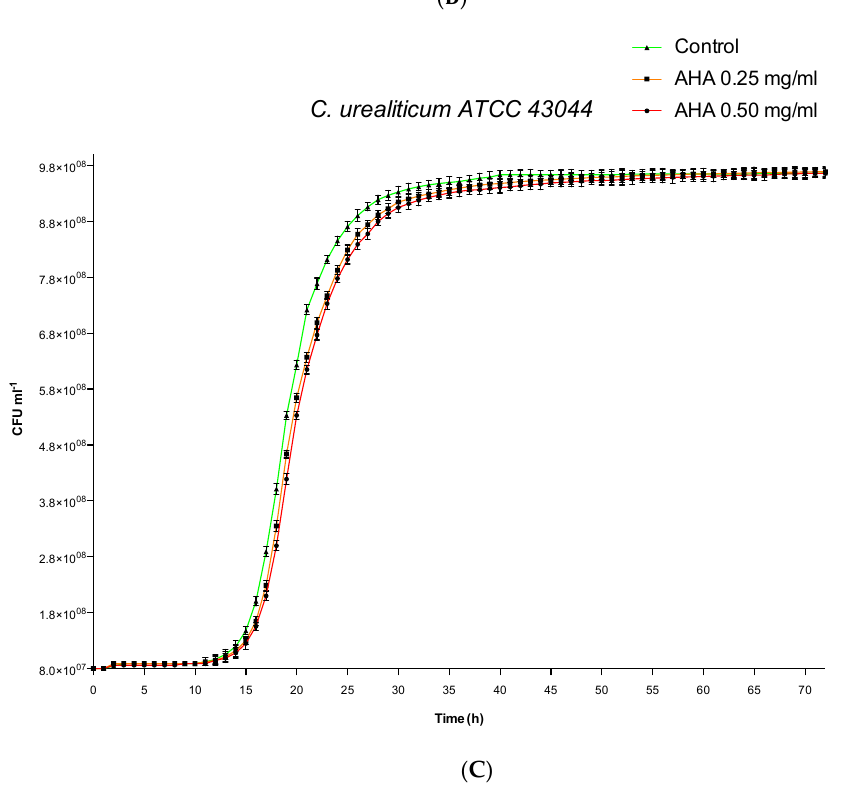
Figure 1. Influence of AHA on in vitro growth curves by cell counting. Green lines: untreated controls. Orange lines: strains treated with AHA 0.25 mg / mL. Red lines: strains treated with AHA 0.50 mg / mL. ( A ) C. urealyticum ATCC 43042. ( B ) C. urealyticum ATCC 43043. ( C ) C. urealyticum 43044. The bars represent means ± SD of independent experiments performed in triplicate (SD = standard